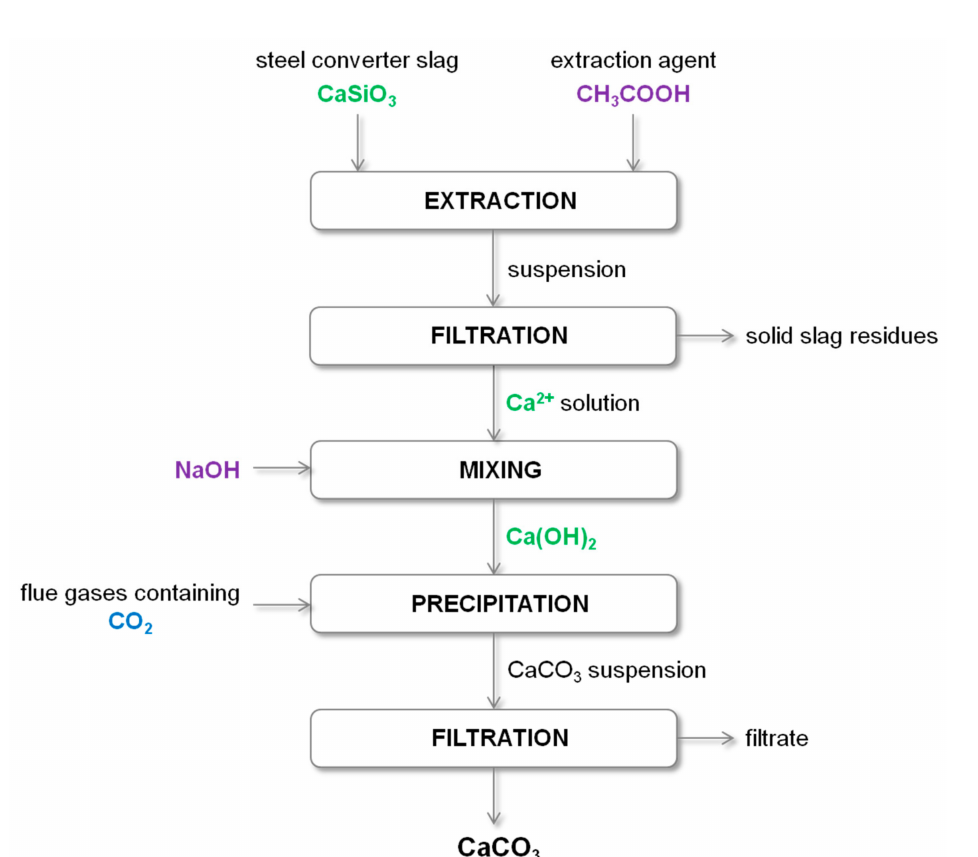
Figure 4. Diagram of the CaCO 3 precipitation process using steel converter slag and CO 2 from flue